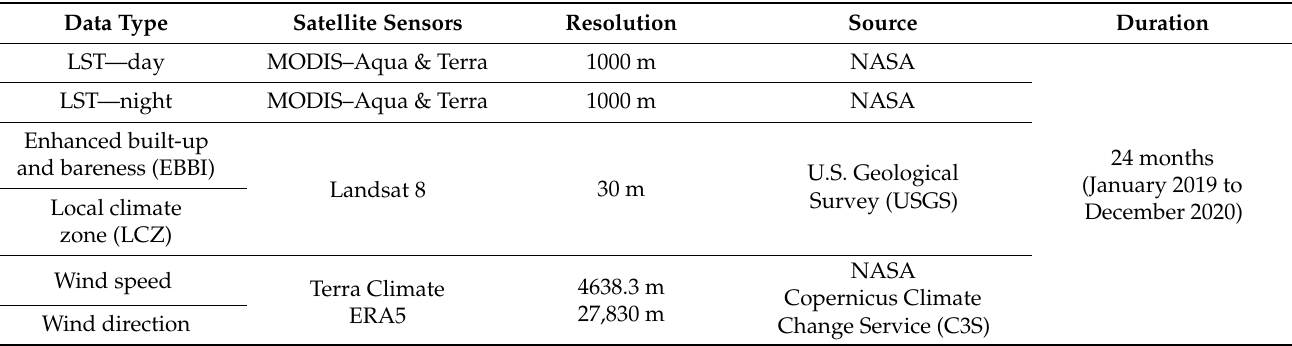
Table 2. Data sources used in the